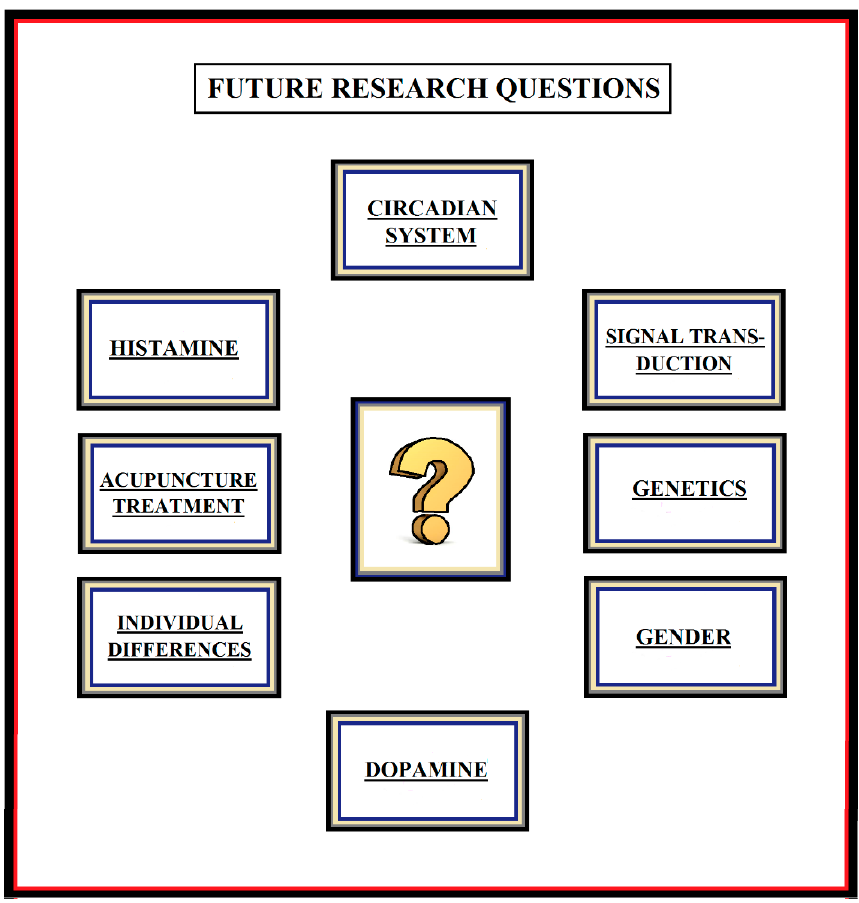
Figure 2. Important research questions that need to be further investigated in future research.